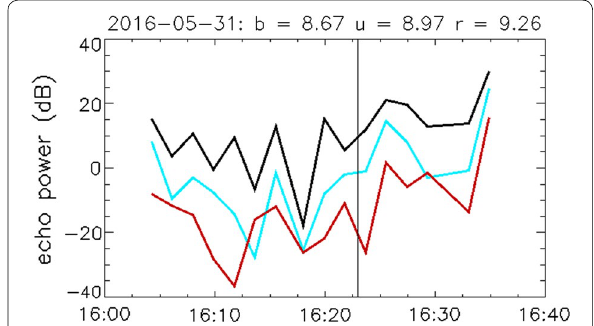
Fig. 11 Time variations of the RASS echo intensity from 16:05 to 16:58 on May 31, 2016, at 8.67 km (black), 8.97 km (blue), and 9.26 km (red) altitudes. The sweep range of the acoustic signal was changed at the timing of the vertical